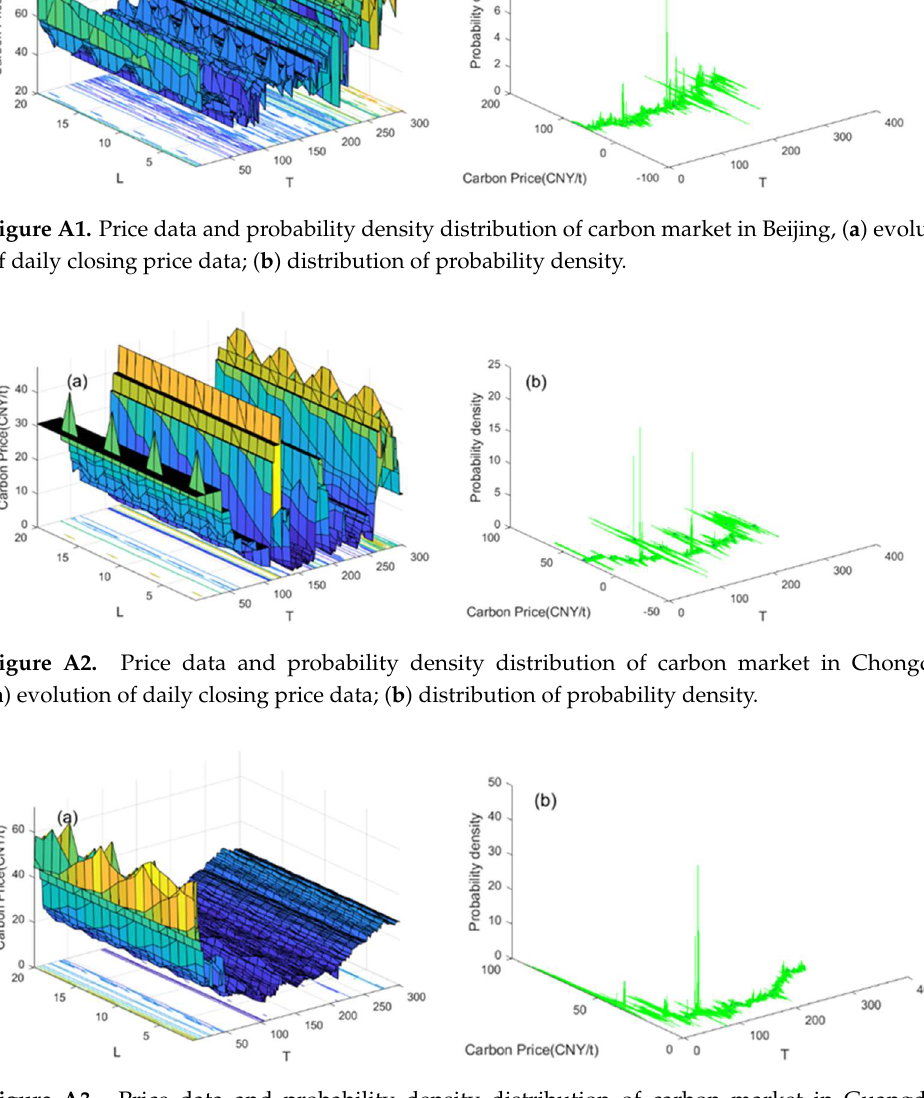
Figure A3. Price data and probability density distribution of carbon market in Guangdong, ( a ) evolution of daily closing price data; ( b ) distribution of probability density.